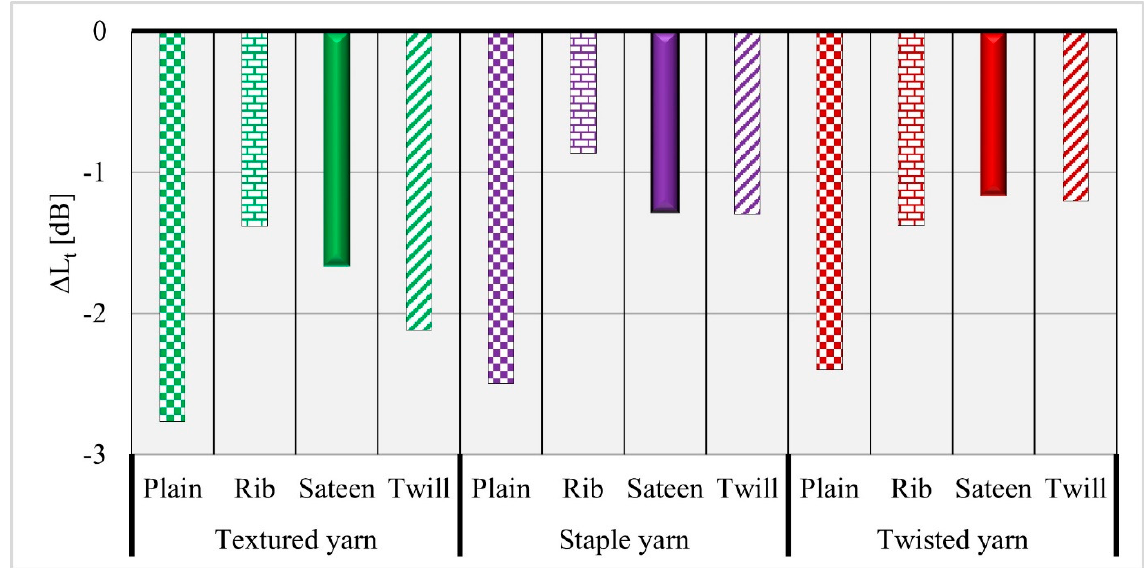
Figure 6. Overall comparison of total sound pressure level drop versus yarn type and fabric structures.